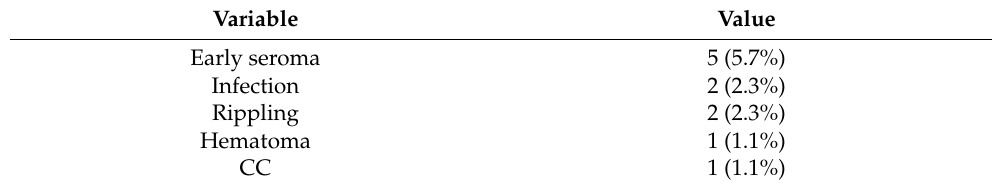
Table 4. Postoperative complications. Figure 4. Illustrative case . A 38-year-old woman received the Motiva Ergonomix TM RoundSilkSur- face (ERSF, 335 cc) for both sides of the breast. The patient was satisfied with the aesthetic outcomes (( a ): preoperatively and ( b ): 3 months postoperatively).